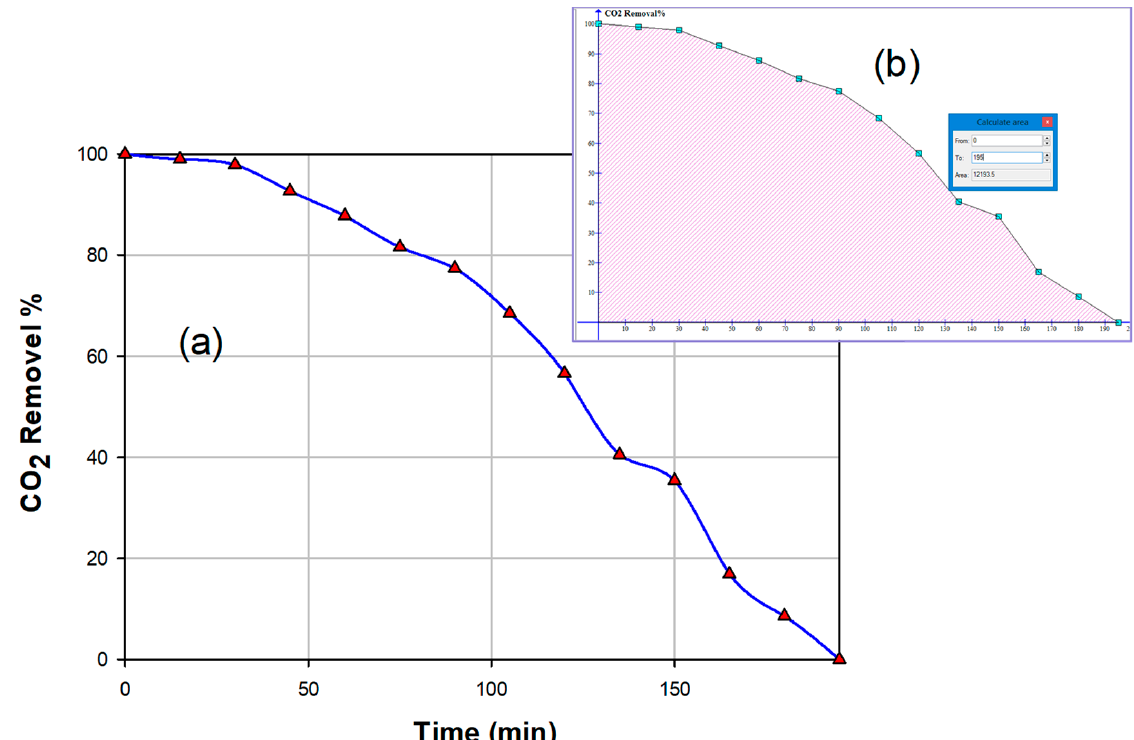
Figure 12. ( a ) CO 2 removal percentage versus time and ( b ) the calculated area under the curve at a gas flow rate of 500 mL/min, room temperature, and atmospheric pressure.